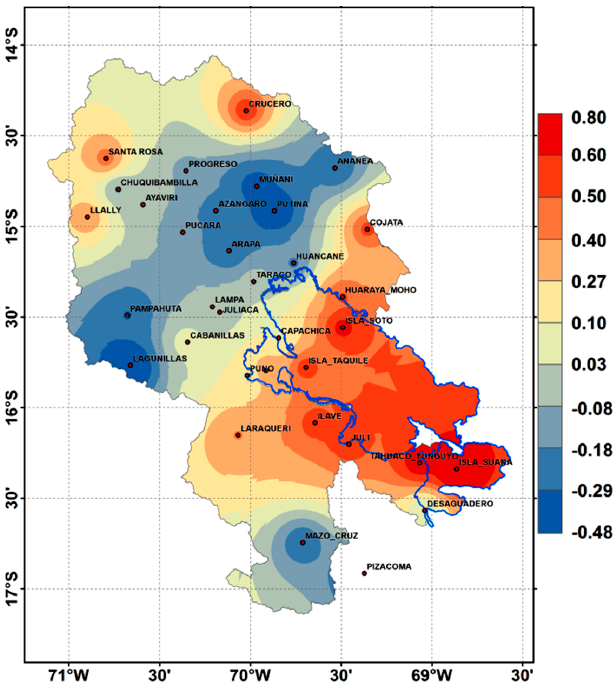
Figure 4. Pearson correlation coefficients (Pearson) of CMORPH with RgSENAMHI for the period 2002–2013.